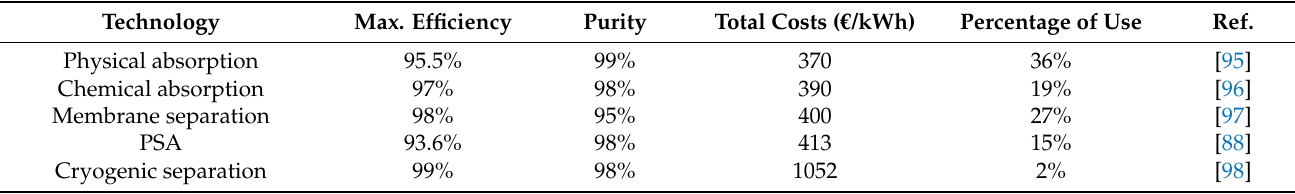
Figure 13. Flow diagram of the cryogenic process [93] .